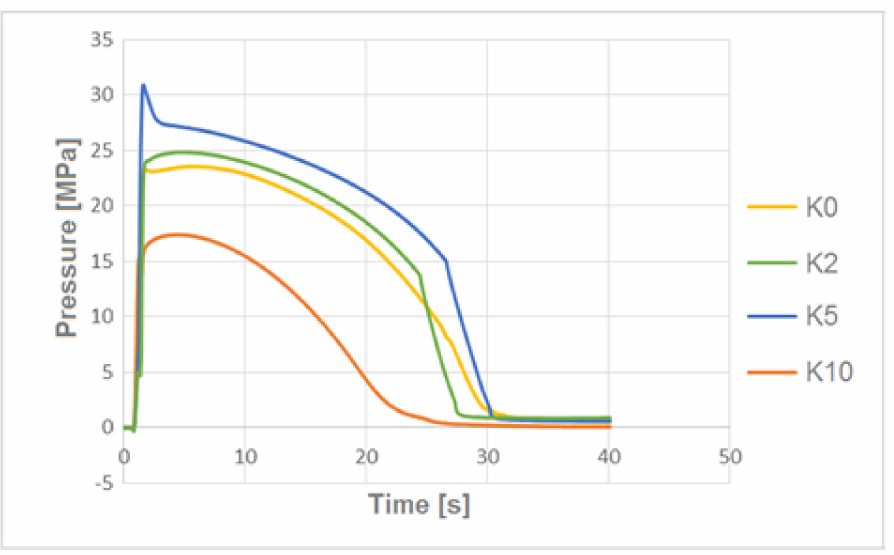
Figure 6. The pressure profiles in the mold cavity for composites filled with unmodified hemp fibers and modified with alkalized 2%, 5% and 10% NaOH solution.